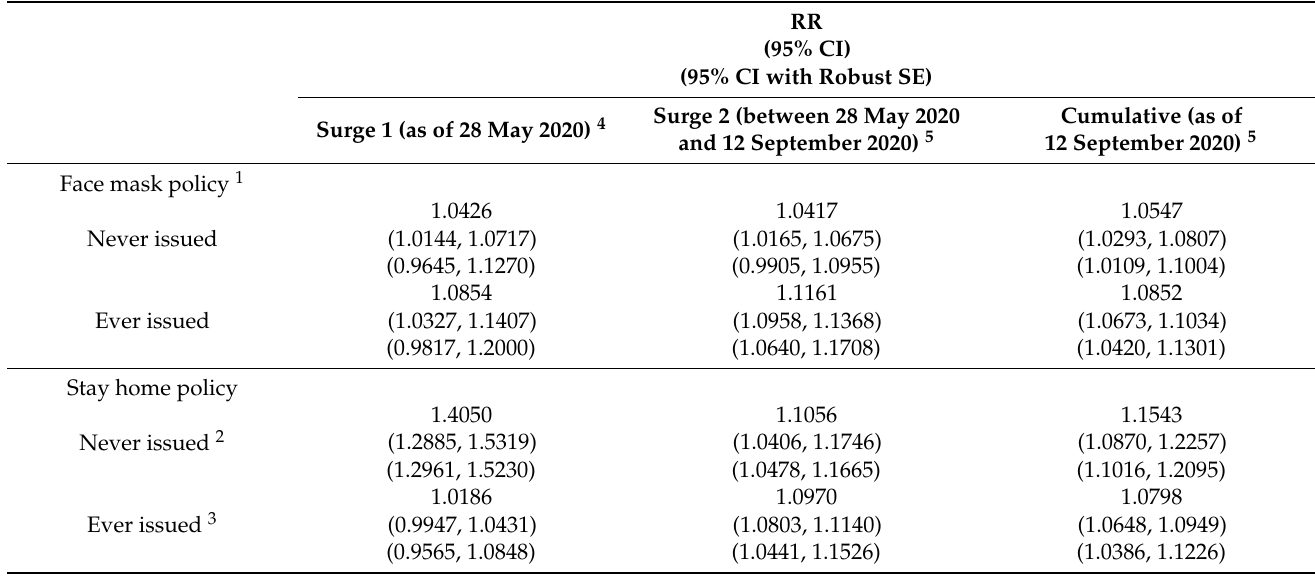
Table 5. Adjusted RRs of COVID-19 associated with 1- µ g/m 3 increase in PM 2.5 by facemask policy and by stay home policy.